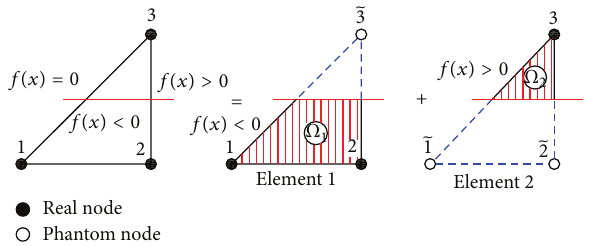
Figure 4: The decomposition of a completely cracked smoothing domain into two superimposed smoothing domains.